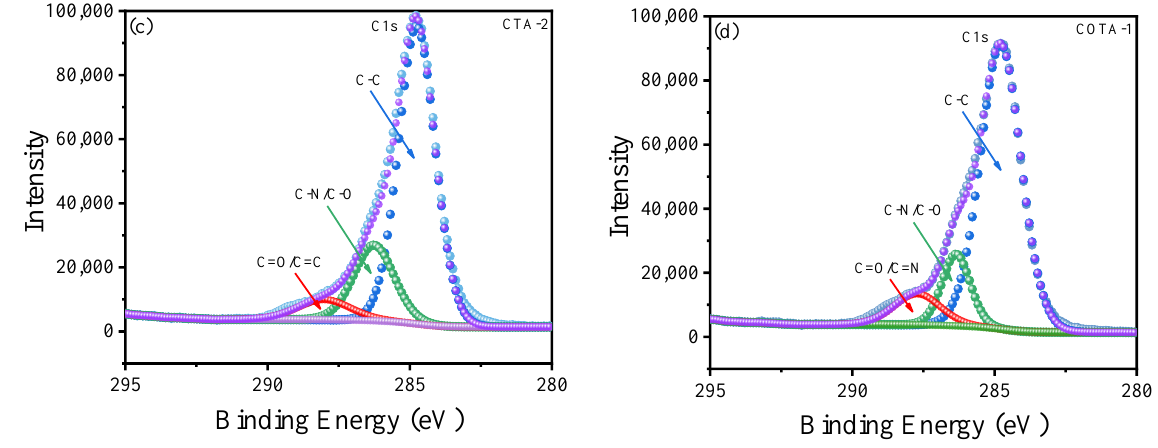
Figure 4. ( a ) XPS full-range spectra for the CS, CTA-2, and COTA-1 films; ( b ) C 1s region of the CS film; ( c ) C 1s region of the CTA-2 film; ( d ) C 1s region of the COTA-1 film.